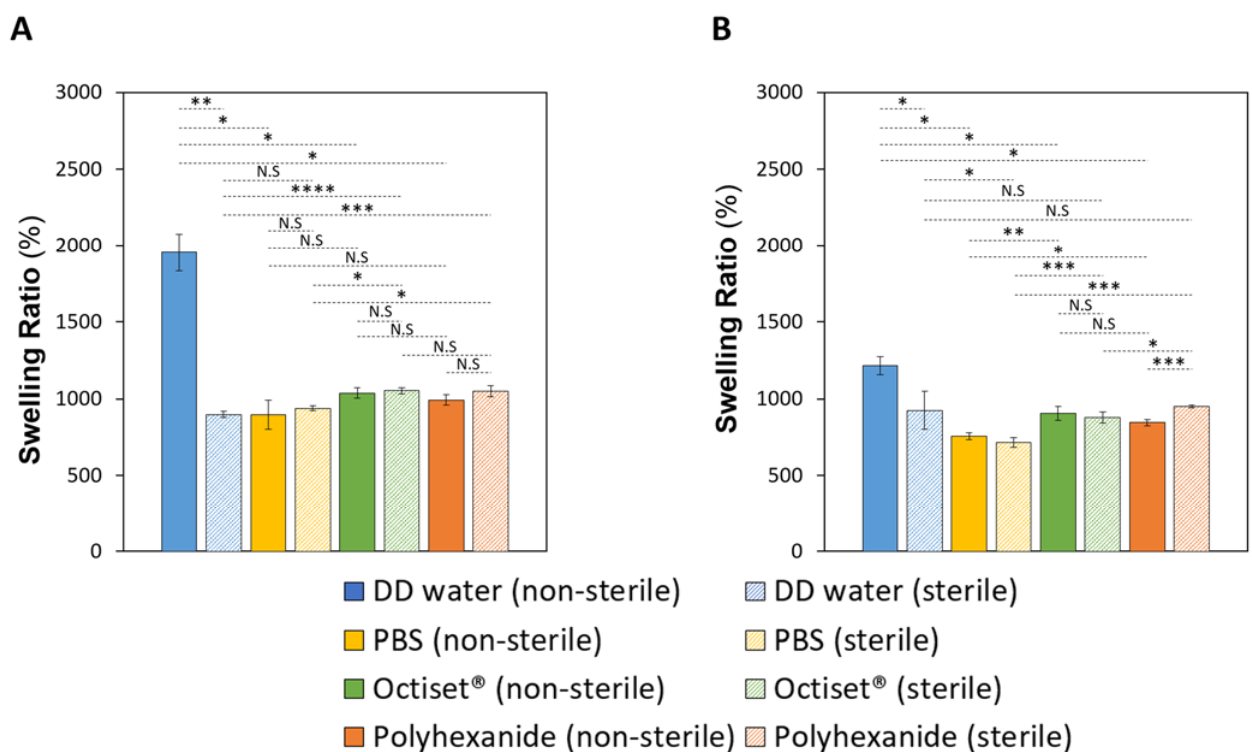
Figure 2. SR of non-sterile and sterile CS ( A ) and C ( B ) hydrogels in DD water, PBS, and drug solu- tions. The errors are the ± standard deviations (n = 3). Statistical analysis was performed using the Student t-test or Wilcoxon signed-rank test, with significance set at * p < 0.05, ** p < 0.01, *** p < 0.005, **** p < 0.001. N.S. = not significant.